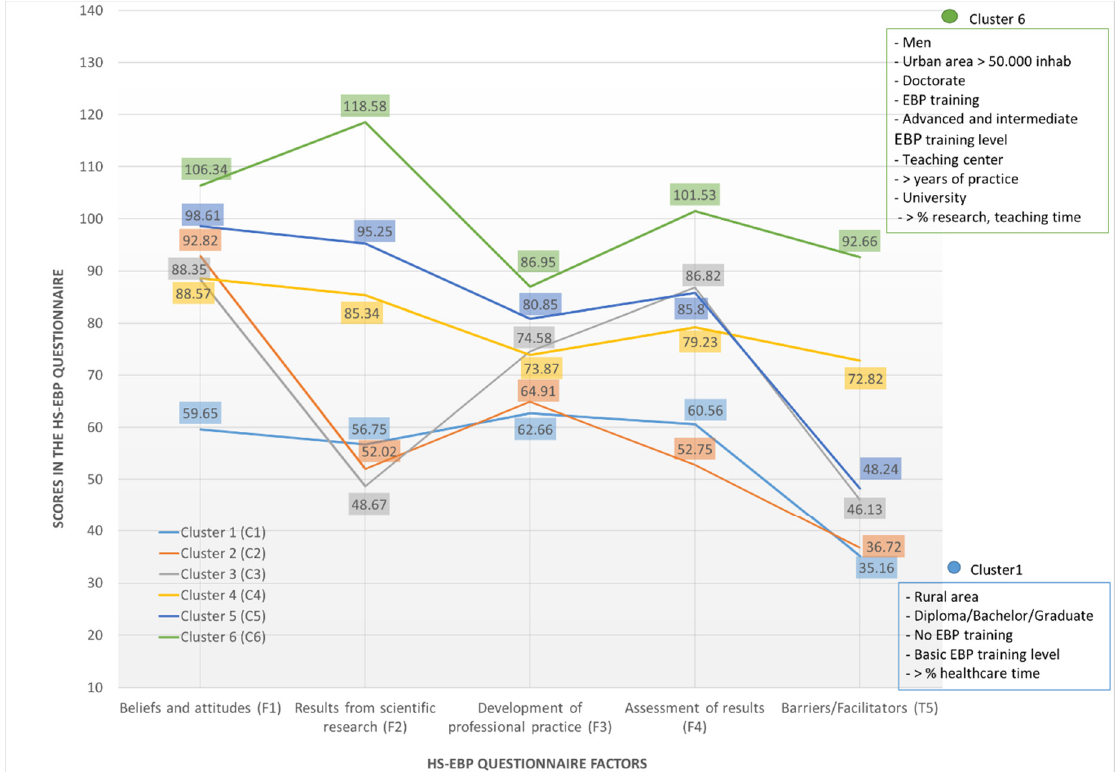
Figure 1. Line diagram showing clusters’ scores behavior through the five HS-EBP dimensions.